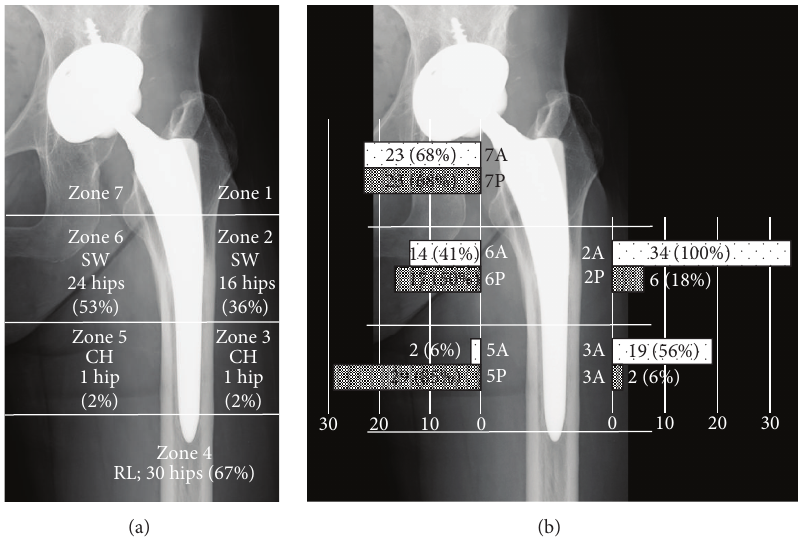
Figure 3: Bone remodeling around the stems (a). SW: spot welds; CH: cortical hypertrophy; RL: reactive lines. (b) Numbers indicate the numbers of hips in which the stem was in contact with the cortical bone using the modified Gruen zone classification.